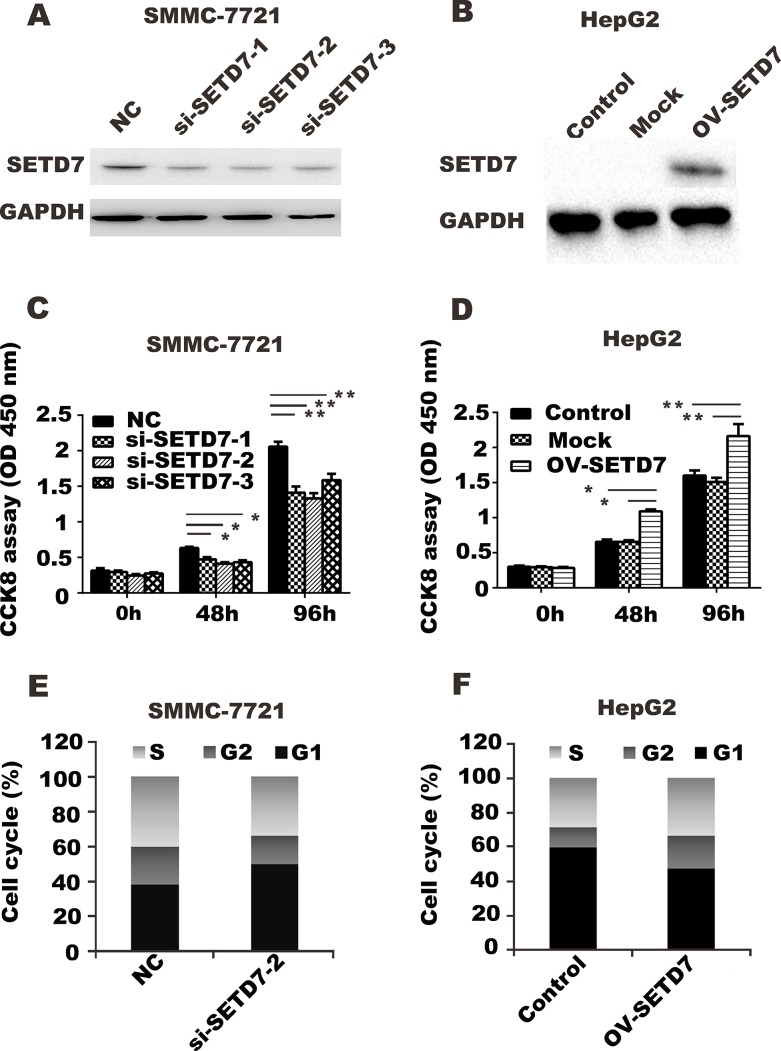
SETD7 expression changes liver cancer cell proliferation by regulating the cell cycle.(A) Western blot analysis was performed to detect the interference efficiency of siRNA after transfected with si-SETD7-1, si-SETD7-2, si-SETD7-3, or scramble RNA (NC) in SMMC-7721. (B) Western blot analysis was performed to detect SETD7 expression in HepG2 transfected with pGV141-SETD7 (OV-SETD7) or pGV141 plasmid (Control). (C, D) CCK8 array was used to assess proliferation in SETD7 knockdown in SMMC-7721 cells or SETD7 overexpression in HepG2 cells. *, P<0.05; **, P<0.01 by student’s t test. (E, F) Cell cycle was assessed in SETD7 knockdown in SMMC-7721 cells or SETD7 overexpression in HepG2 cells by flow cytometry assay.